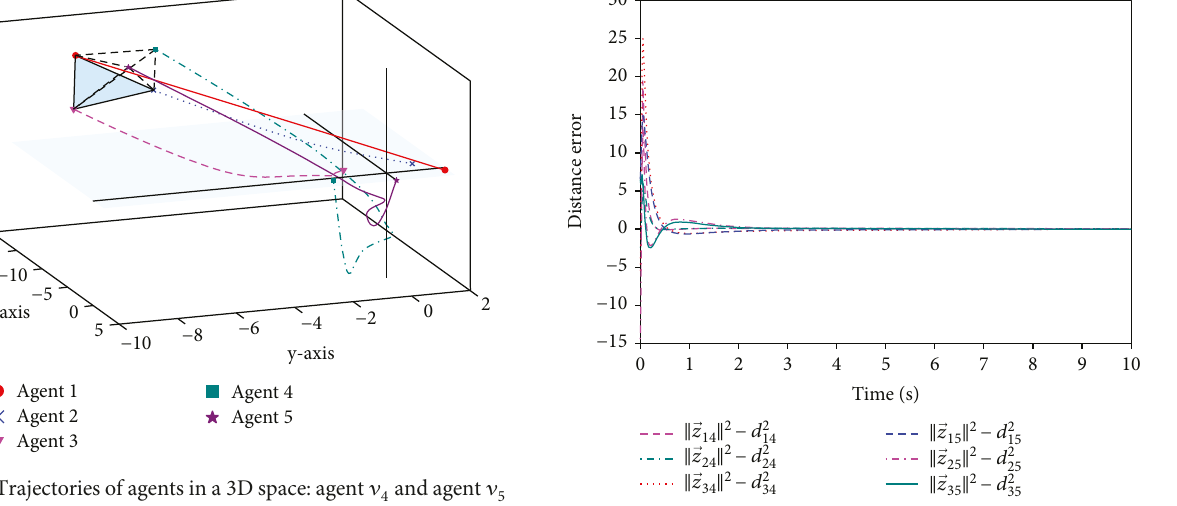
ν 4 and agent 5 are in the same